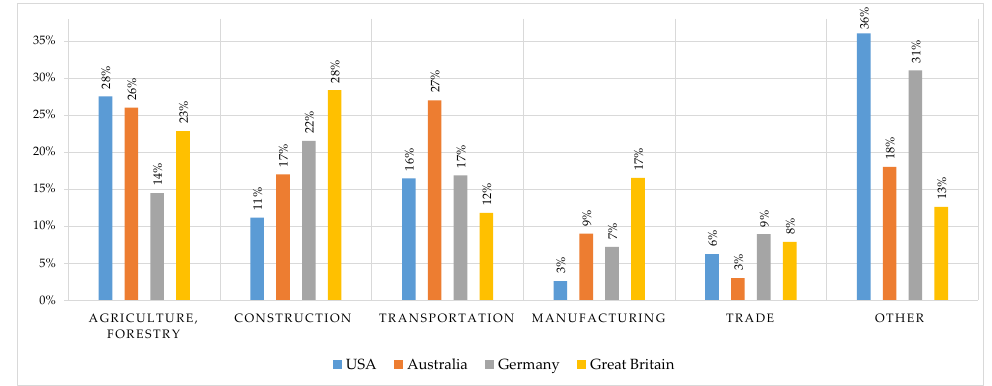
Figure 2. The rate of deaths due to work-related accidents during 2014–2020 (for approx. 100,000). The most dangerous identified industry sectors are agriculture/forestry,